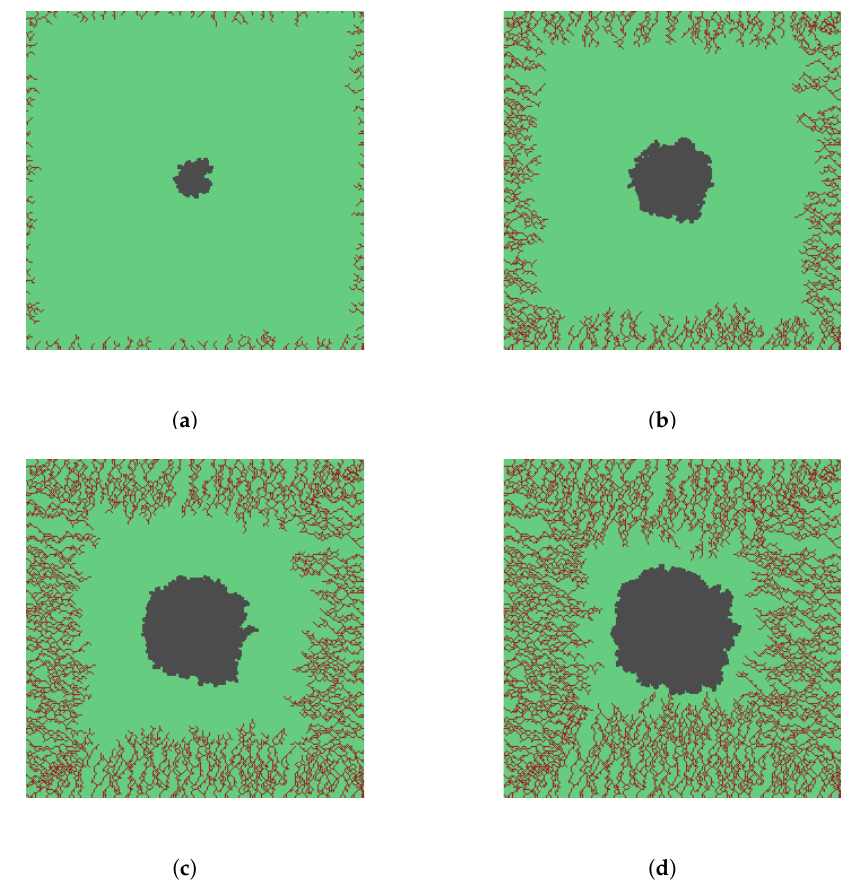
Figure 11. Eden model simulation of angiogenesis and bacteria infection for a square skin wound. is wound space, is vasculature growth and and is bacteria growth. Compared to the initial wound, vascularization and bacteria burden at the different stages are approximately ( a ) 10% and 1% ; ( b ) 38% and 4%; ( c ) 59% and 8%; and ( d ) 78% and 11%. The capillary growth rate is 1 step, the branching length is 2 steps and the bacteria growth rate is half a